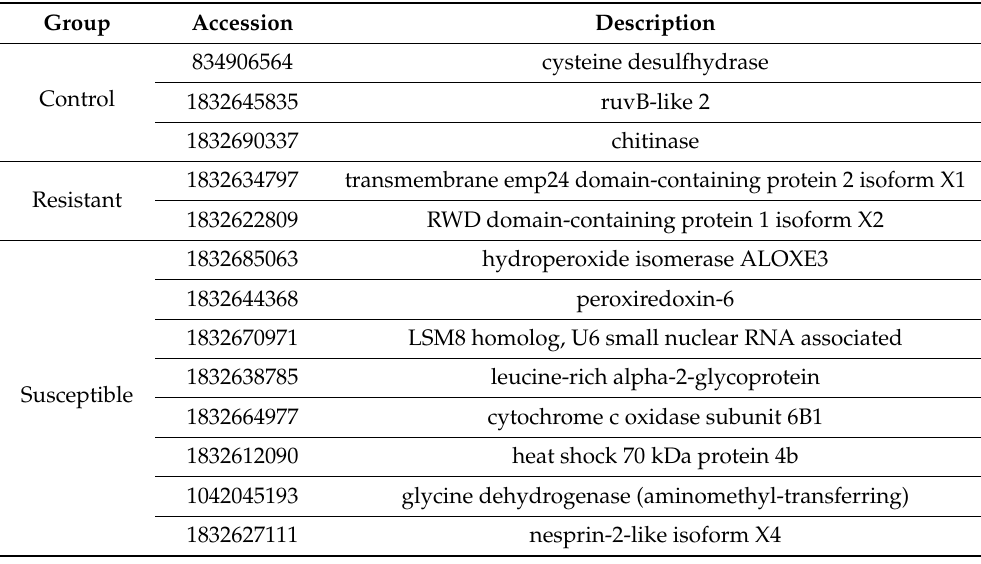
Figure 2. Venn diagram that summarized the total number of putative proteins identified in control, resistant and susceptible groups, respectively, in response to Vibrio alginolyticus experimental infection. Table 1. Putative proteins were found to be exclusively expressed in the control, resistant and susceptible groups, respectively.